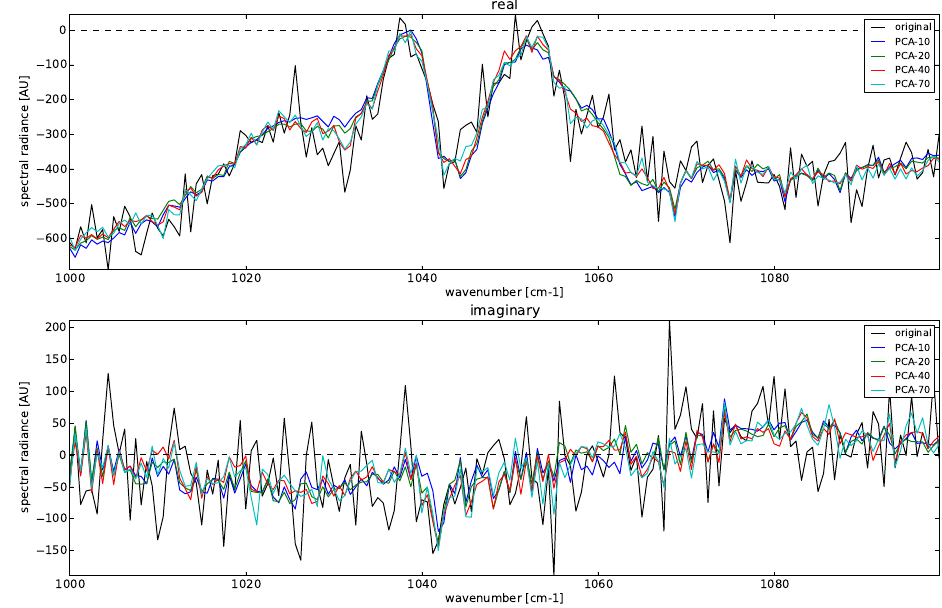
Figure 9. Reconstructions of the same DS spectrum as in Figs. 6 and 8, in the spectral range between 1000 and 1100cm − 1 . The obvious discrepancies between the reconstructions and the original spectrum are due to residual emissions from stratospheric trace gases.